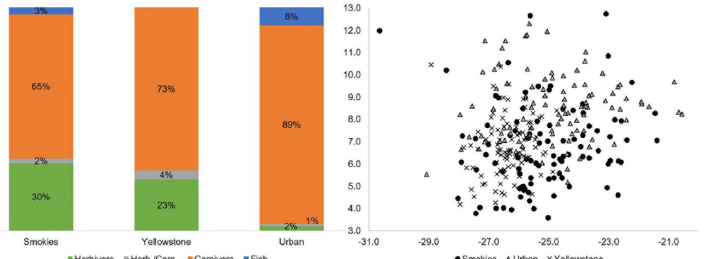
Fig 4. Putative carcass trophic values transformed from wild fly data by mean experimental fractionation factors for females. Panel A: Proportion (out of 100%) of wild flies from urban, Smokies, and Yellowstone regions with isotopic signatures indicative of four carcass trophic positions: herbivore (green), herbivore/carnivore (grey), carnivore (orange), fish (blue). Panel B: Summary of results from wild flies are illustrated via scatterplot with δ 15 N given on the y-axis and δ 13 C values on the x-axis. Black circles = flies from the Great Smoky Mountains National Park; grey triangles = flies from the urban environment (Indianapolis, IN, USA); black X’s = flies from Yellowstone National